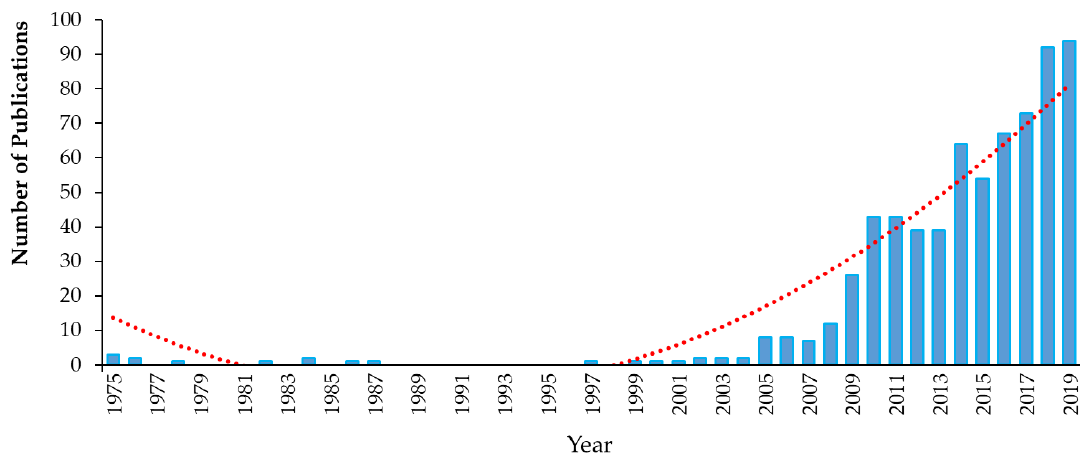
Figure 5. Number of scientific documents on the topic of “triclocarban” published for the time period from 1975 to 2019 (data generated from reference [74]).